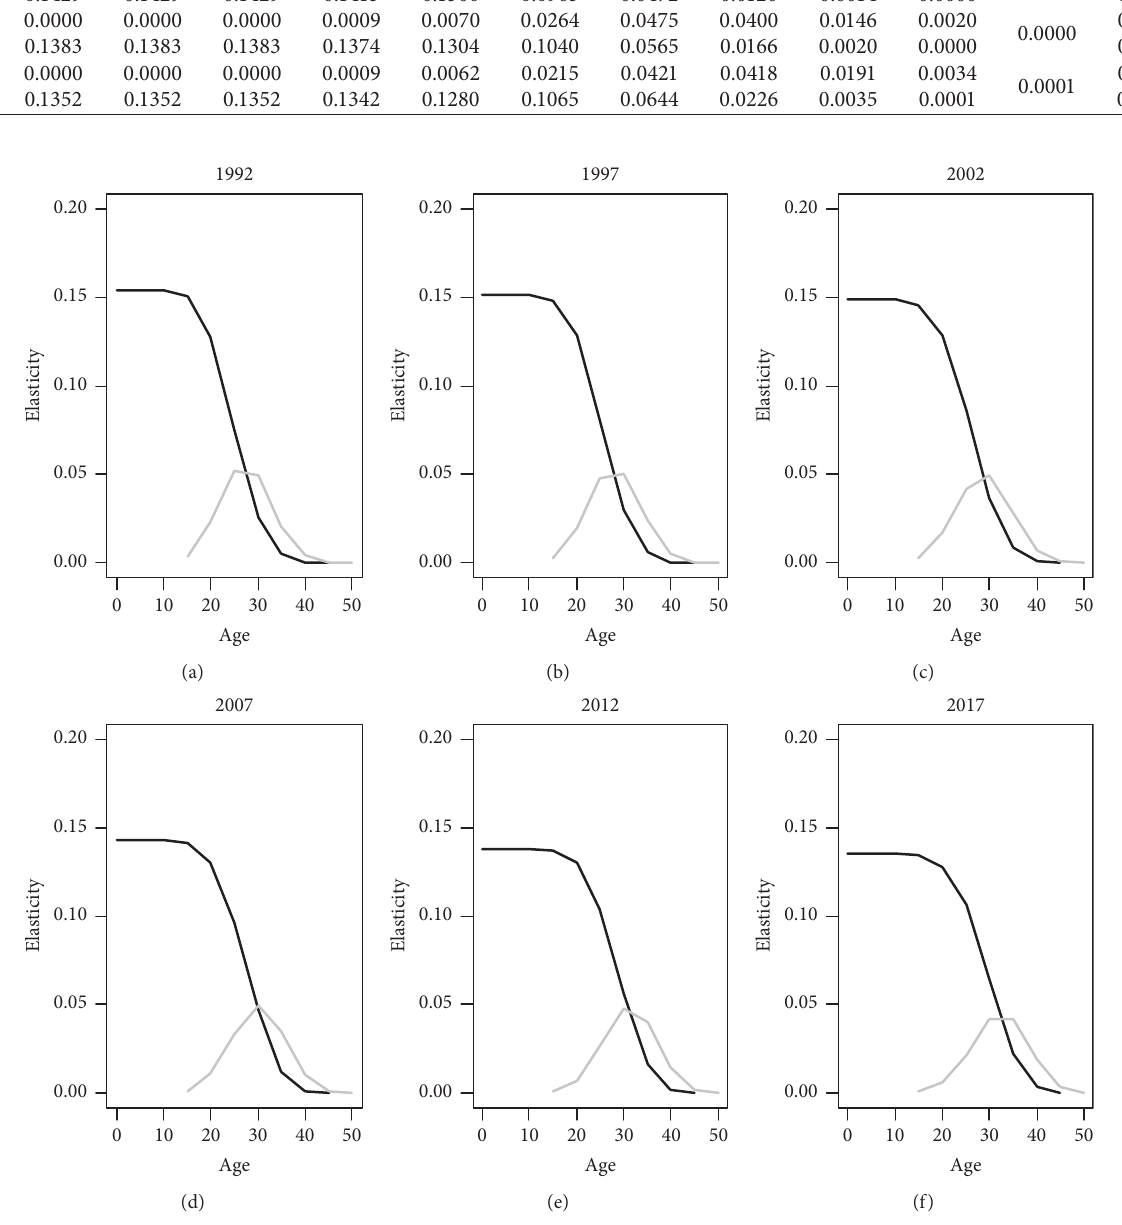
Figure 7: Elasticities to age-specific survival in black and fertility in